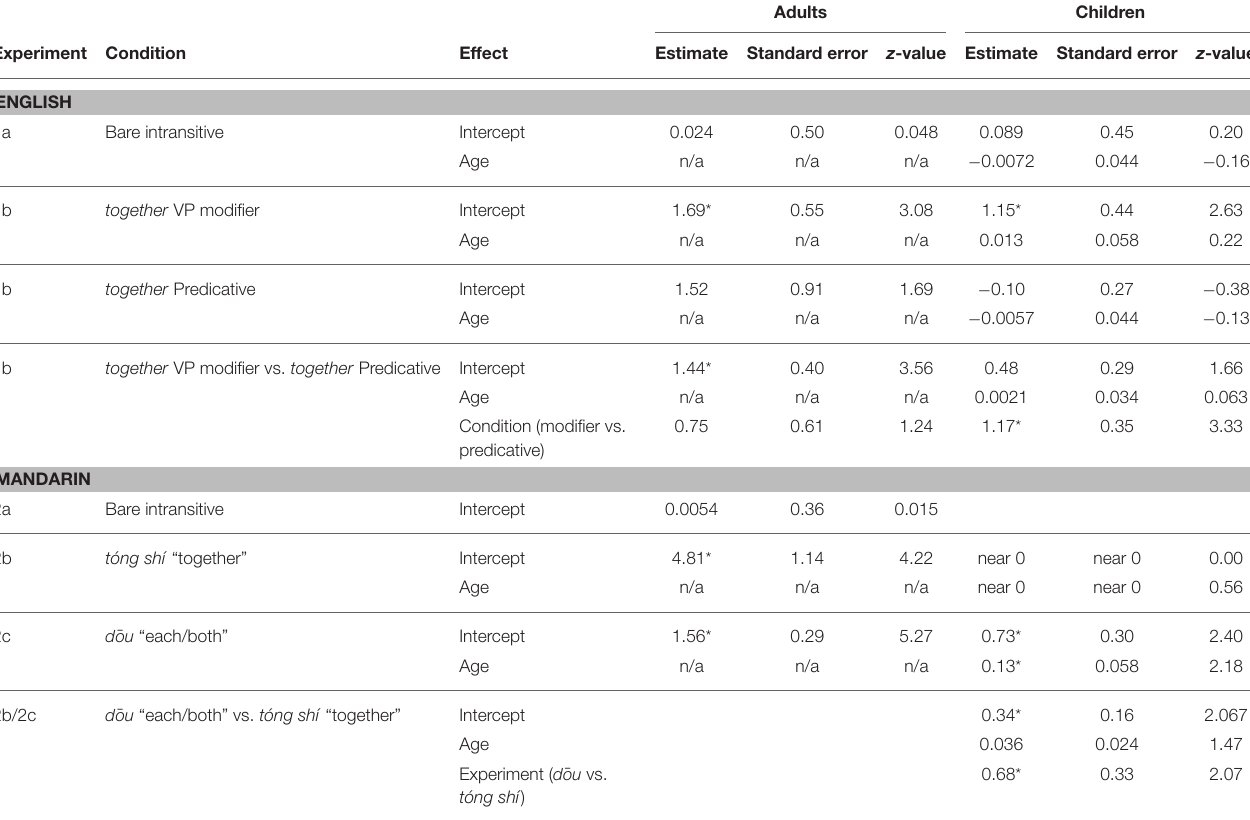
TABLE 4 | Parameter estimates from all